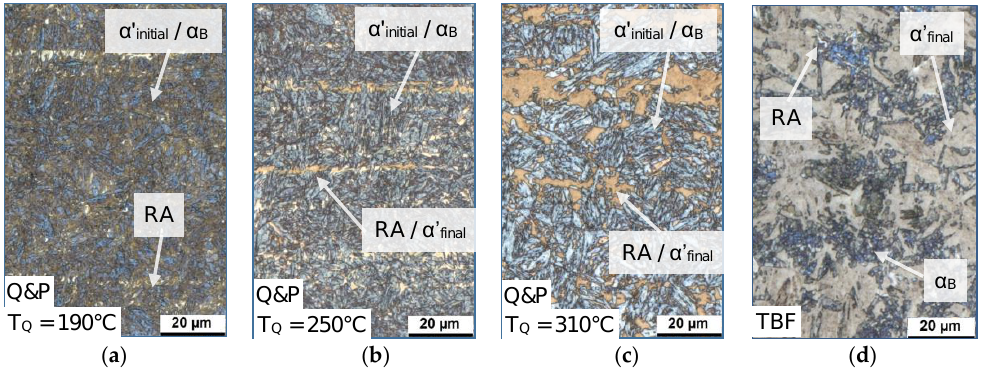
Figure 6. Light optical microscopy (LOM) images of the ( a – c ) Q&P samples ( T Q = 190, 250, and 310 °C) and ( d ) TBF sample at a T P ( T B ) of 400 °C (magnification 1000×).